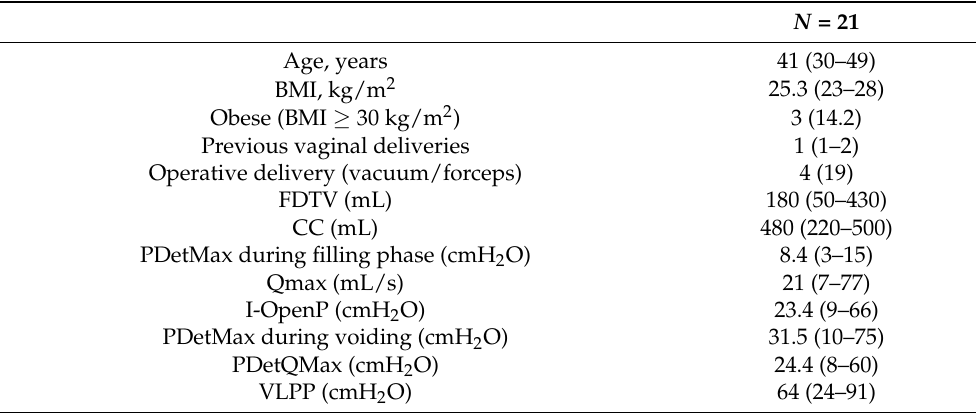
Table 1. Baseline characteristics of the study